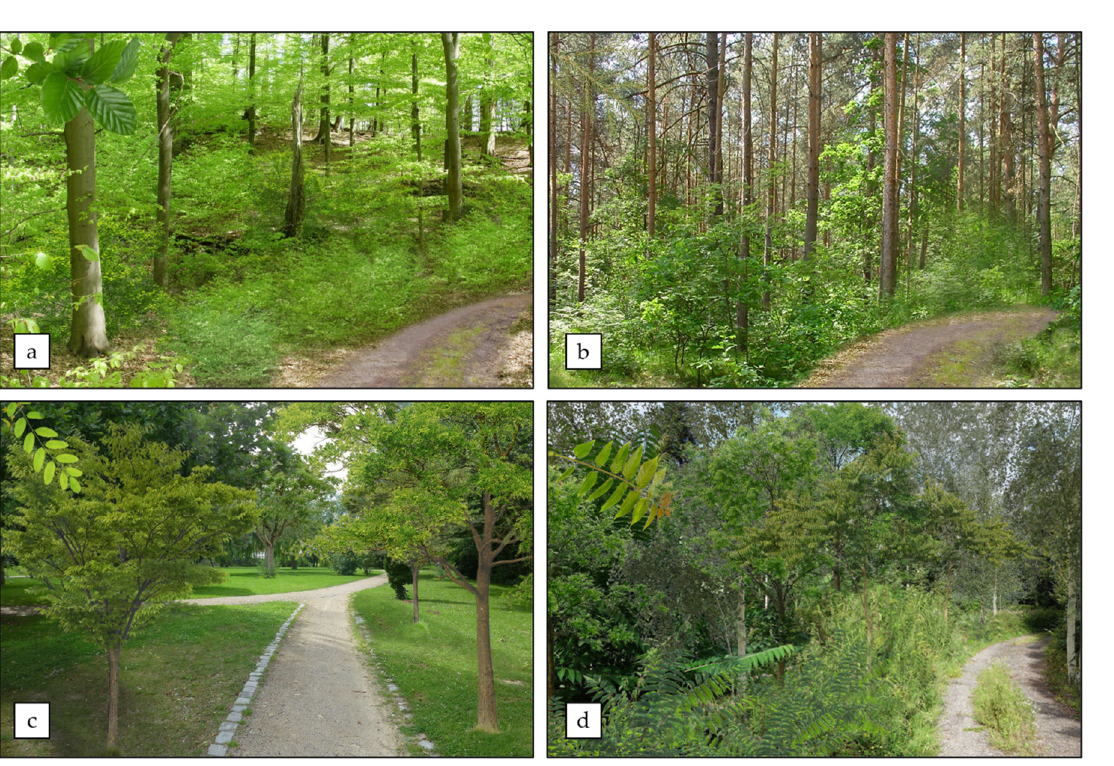
Figure 1. Photographic stimuli depicting four forest types ( a – d ) typical of the Berlin region and differentiated according to the four natures concept [42,53] (Table 1): ( a ) nature 1 represented by a beech forest as natural remnant, dominated by the native Fagus sylvatica , ( b ) nature 2 represented by a silvicultural plantation, dominated by the native Pinus sylvestris , ( c ) nature 3 represented by a designed tree-dominated urban park with the non-native Robinia pseudoacacia , ( d ) nature 4 represented by a novel wild woodland dominated by the non-native Ailanthus altissima . A small branch with leaves of characteristic tree species is shown as inserts on the top left. Information about the prevailing management of the shown forest types and the origin (native/non-native) of the dominant tree species was provided in a text above each photograph.